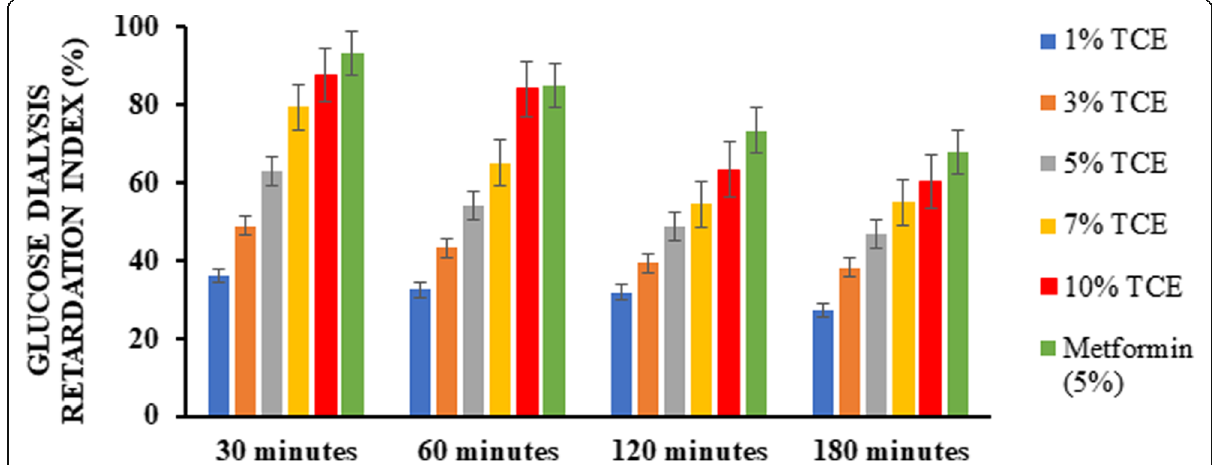
Fig. 2 GDRI (%) of TCE samples relative to Metformin (5%) as a function of concentration